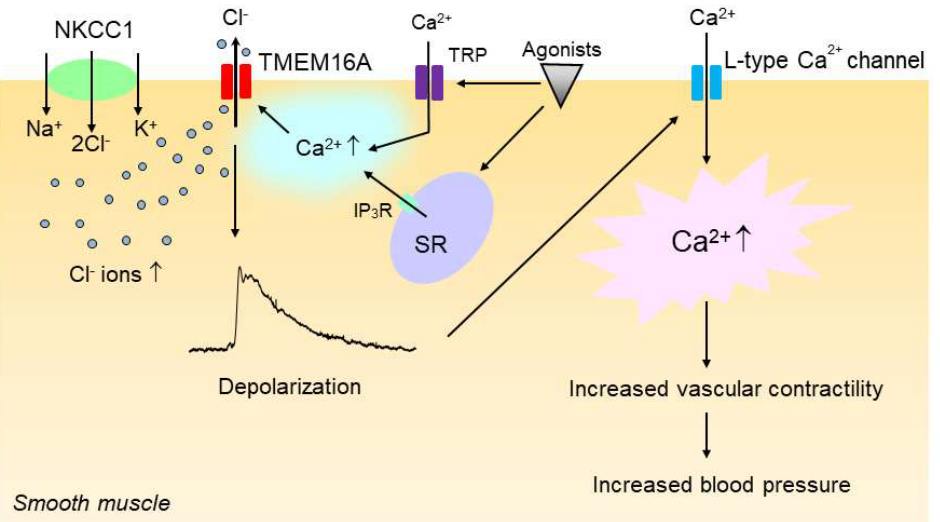
Figure 4. Upregulation of smooth muscle Na + –K + –2Cl − cotransporter 1 (NKCC1) and TMEM16A additively and sequentially increases vascular contractility in hypertension. In hypertension, the intracellular concentration of Cl − is increased in vascular smooth muscle cells because of the in- creased activity of NKCC1. The increase in the intracellular Cl − concentration then increases the driving force for Cl − efflux via the Ca 2+ -activated Cl − channel TMEM16A when TMEM16A is acti- vated by intracellular Ca 2+ rise upon stimulation with vasoconstricting agonists, which in turn in- duces membrane depolarization. TMEM16A might be regulated by a local Ca 2+ increase that could be generated by IP 3 R channels on the sarcoplasmic reticulum (SR) and/or transient receptor poten- tial (TRP) channels. The membrane depolarization would then enhance the open probability of volt- age-gated L-type Ca 2+ channels, leading to an increase in vascular contractility and blood pressure.